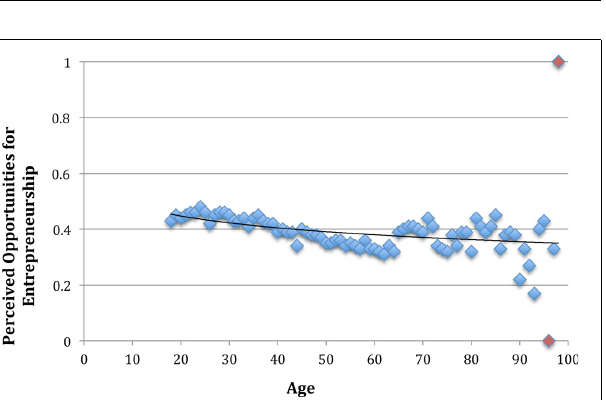
FIGURE 2 | Plot of entrepreneurial activity across the lifespan (18–97 years). The trendline depicts the logarithmic relationship between age and entrepreneurial activity.